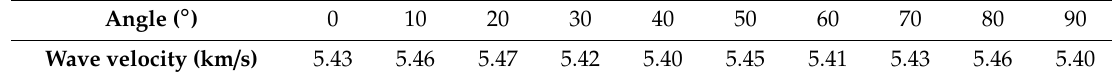
Table 3. Average wave velocity in each direction.